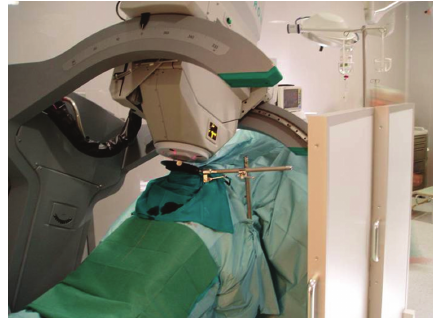
Figure 3: Dedicated linear accelerator (Mobetron, Intraop, Sunny- vale, CA) installed in the operating